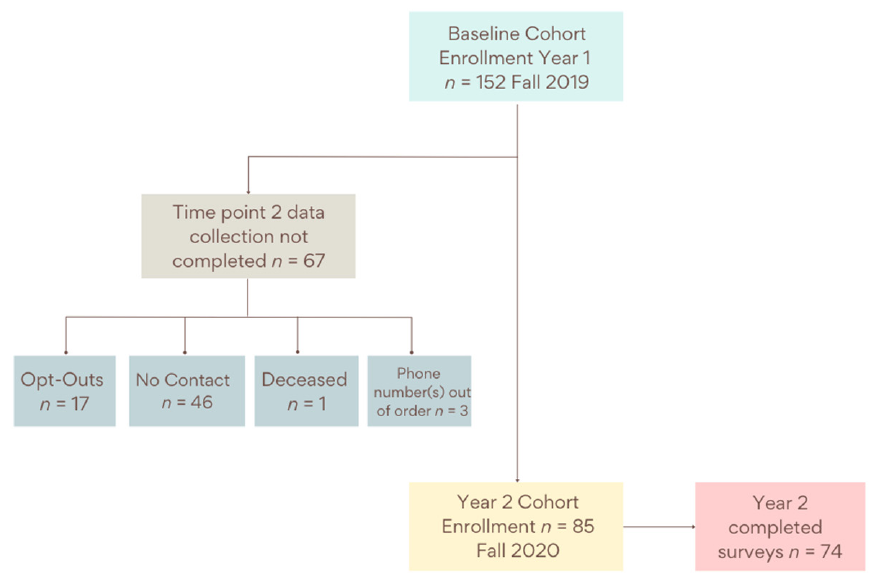
Figure 2. Time point two enrollment process from time point one among HOP project cohort study